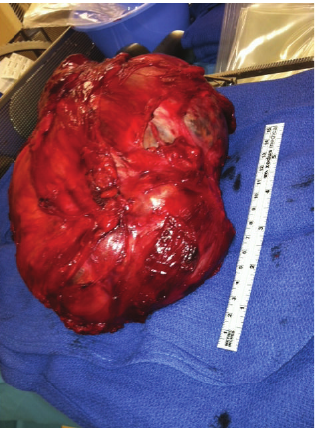
Figure 2: The gross specimen of a well-encapsulated 21 × 15 × 13cm retroperitoneal mass.